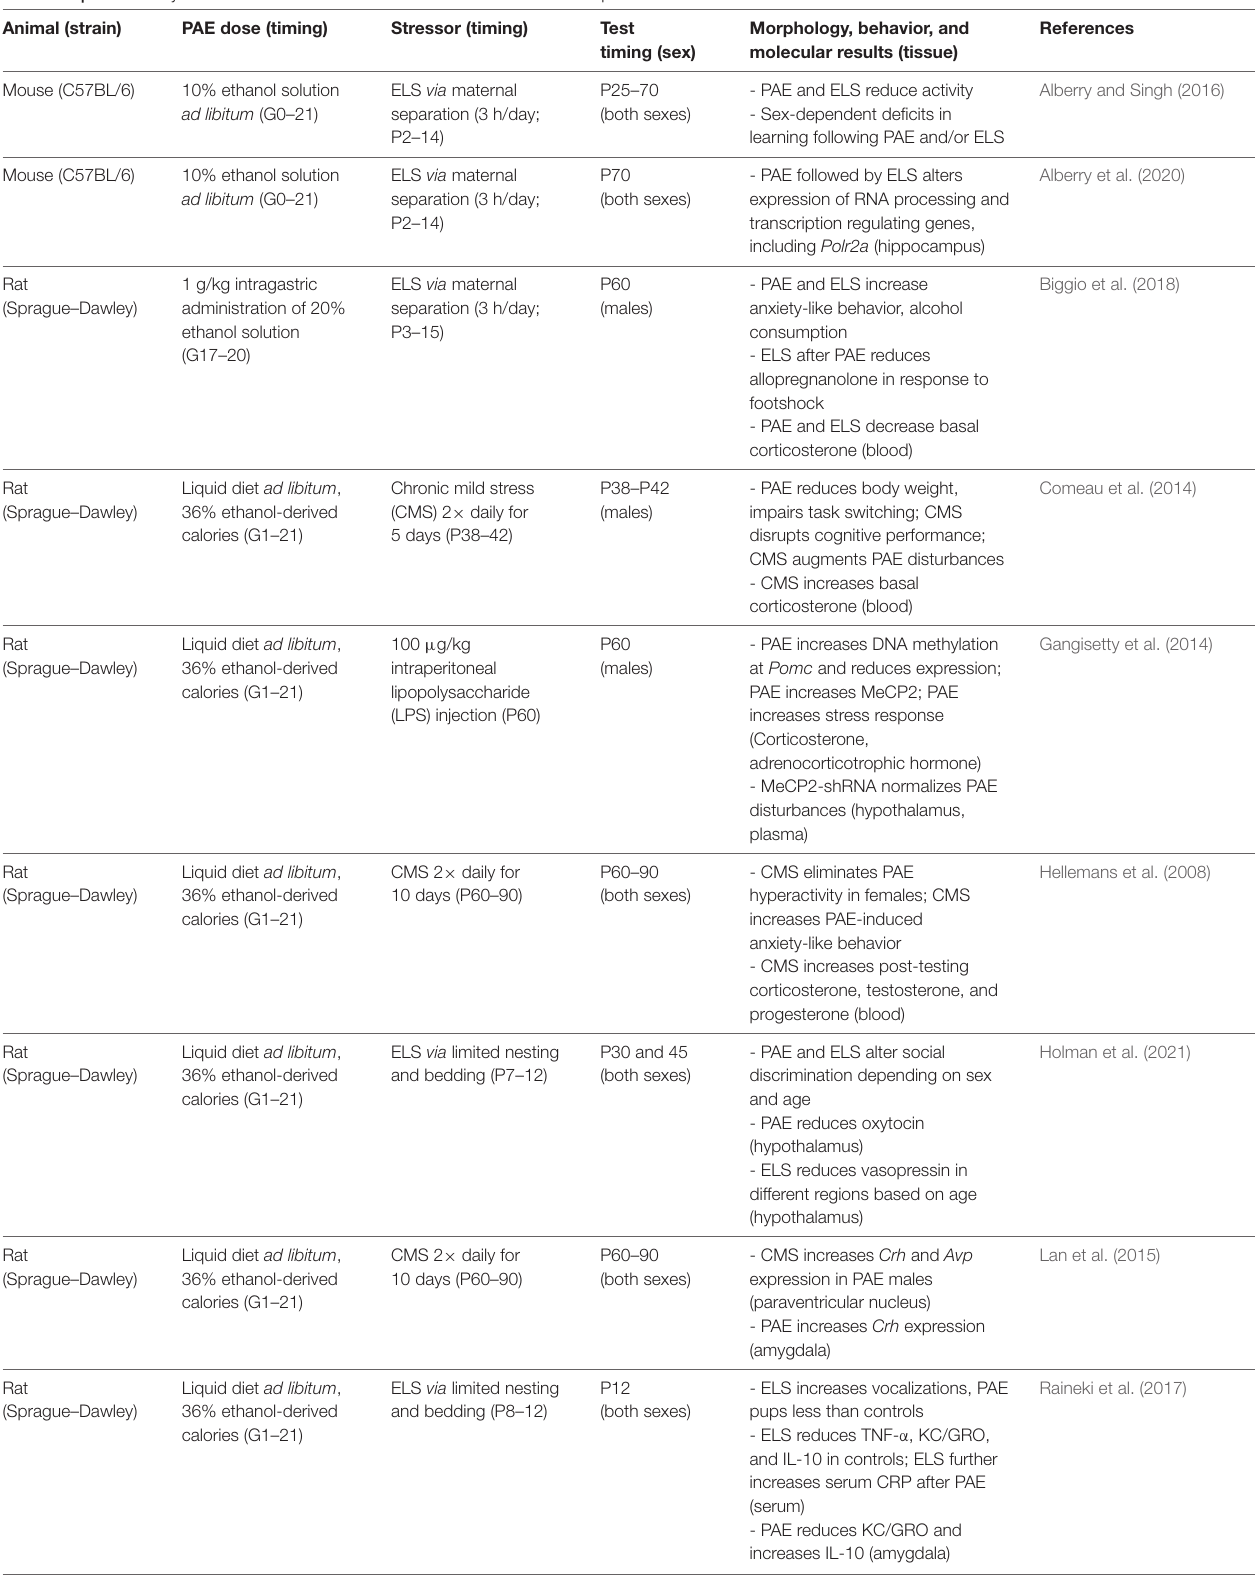
TABLE 1 | A summary of rodent models of FASD that include PAE as well as a postnatal stressor in the